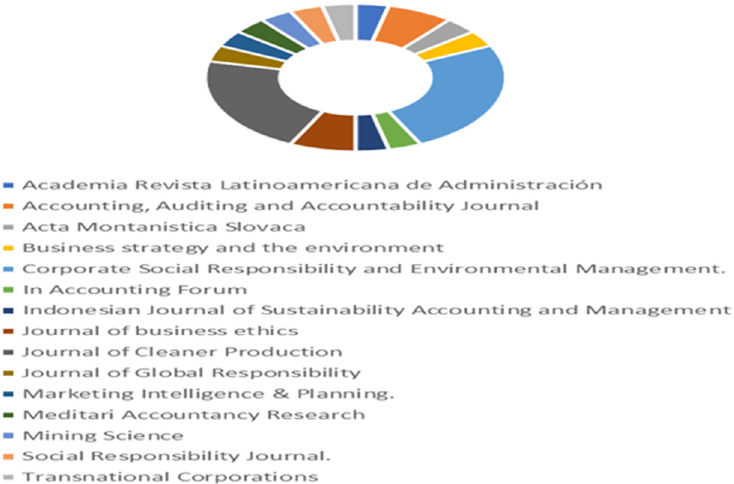
Figure 4. Journals (Wos and Scopus).